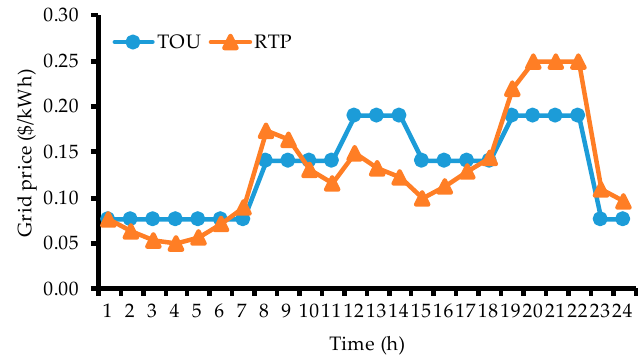
Figure 4. TOU (time of use) and RTP (real-time pricing) tariffs.